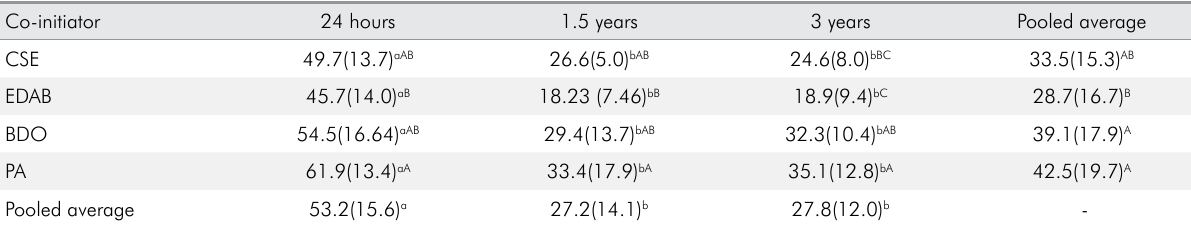
Table. Bond strength (means (standard deviations)), in MPa, of adhesives evaluated. Co-initiator